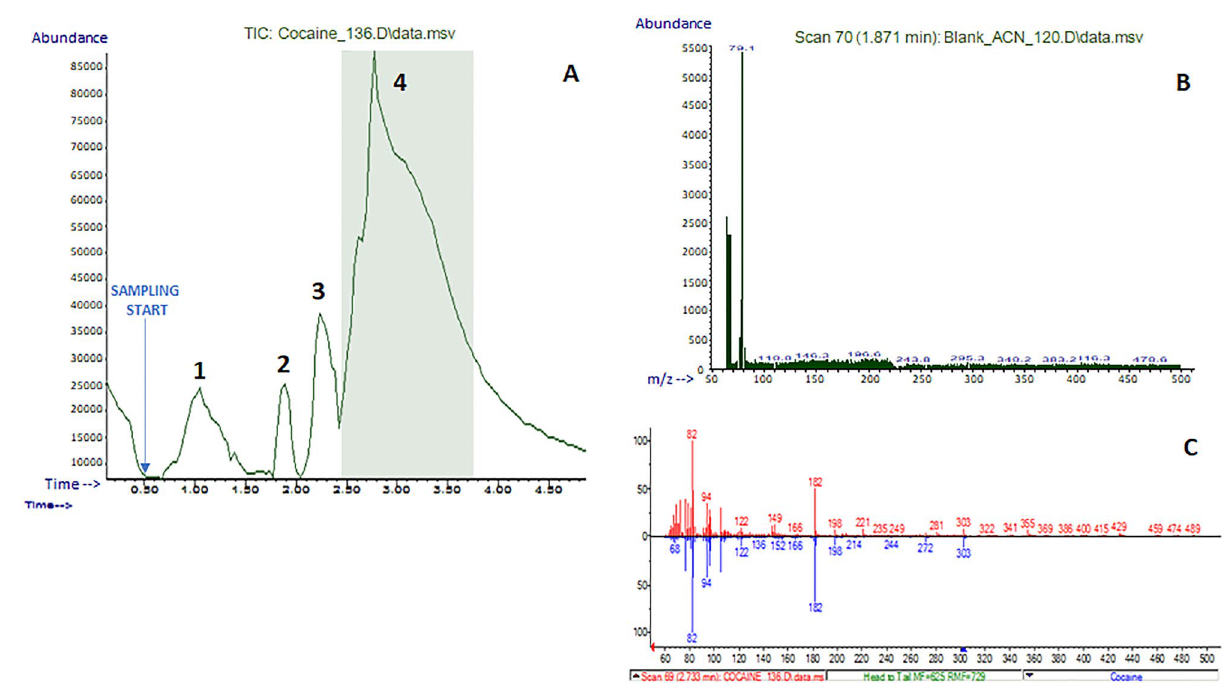
Figure 6. ( A ) Analysis of spots 1–3 (intact) and 4 (cocaine) on a banknote: TIC; ( B ) EI experimental full spectrum of a negative spot (matrix); ( C ) NIST library spectrum matching: red, experimental spectrum; blue, library spectrum. The arrow indicates the sampling